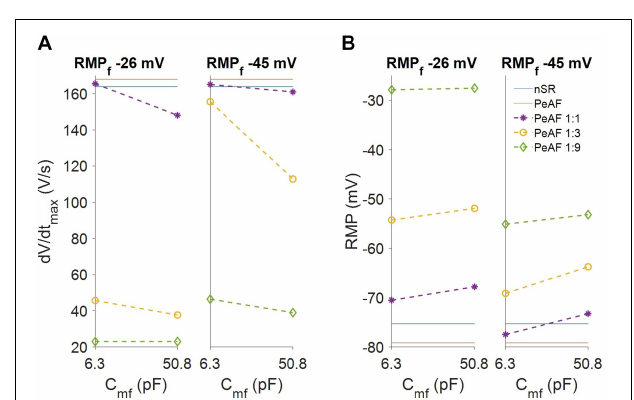
FIGURE 4 | Fibroblasts coupling effect on myocyte electrophysiology. (A) Myocyte maximum upstroke velocity (dV/dt max ). (B) Myocyte resting membrane potential (RMP). The levels for myocytes in normal sinus rhythm (nSR) and persistent atrial fibrillation (PeAF) conditions are given in blue and red, respectively. Discontinuous lines are myocytes in PeAF coupled to one fibroblast (1:1), 3 (1:3), or 9 (1:9).